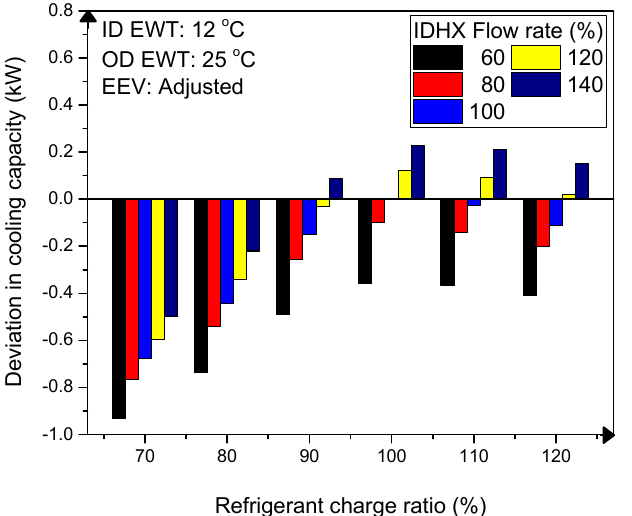
Figure 3. Deviation in reference capacity according to refrigerant charge and indoor heat exchanger flow rate combined faults.